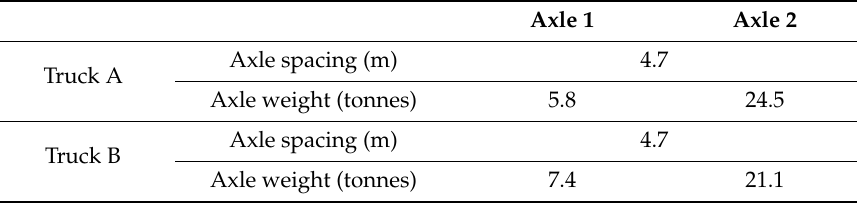
Table 2. Vehicle characteristics.